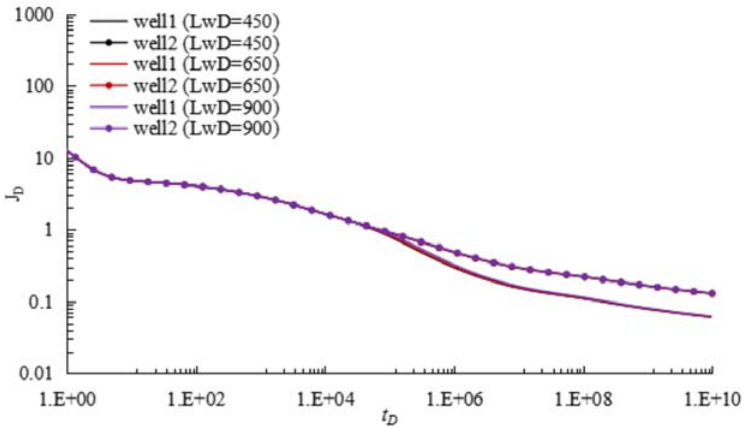
Figure 10. Effects of well spacing on MPI for WIPS scheme.